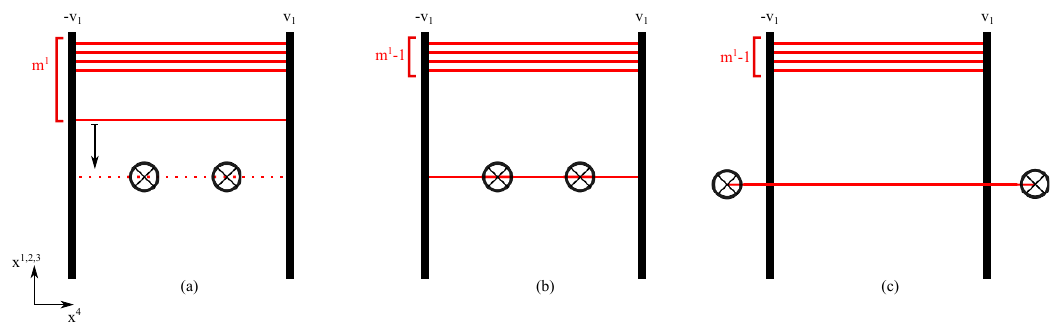
Figure 3 . This (cid:12)gure illustrates how Hanany-Witten transformations of our brane system can be used to show that monopole bubbling is non-singular. (a) We consider a system of 2 parallel D3- branes (black lines) with m 1 D1-branes (red lines) stretched between them and spatially transverse NS5-branes (black (cid:10) ). (b) We move a single D1-brane down so that it is spatially coincident with the NS5-branes. (c) We can pull the NS5-branes through the D3-branes by performing